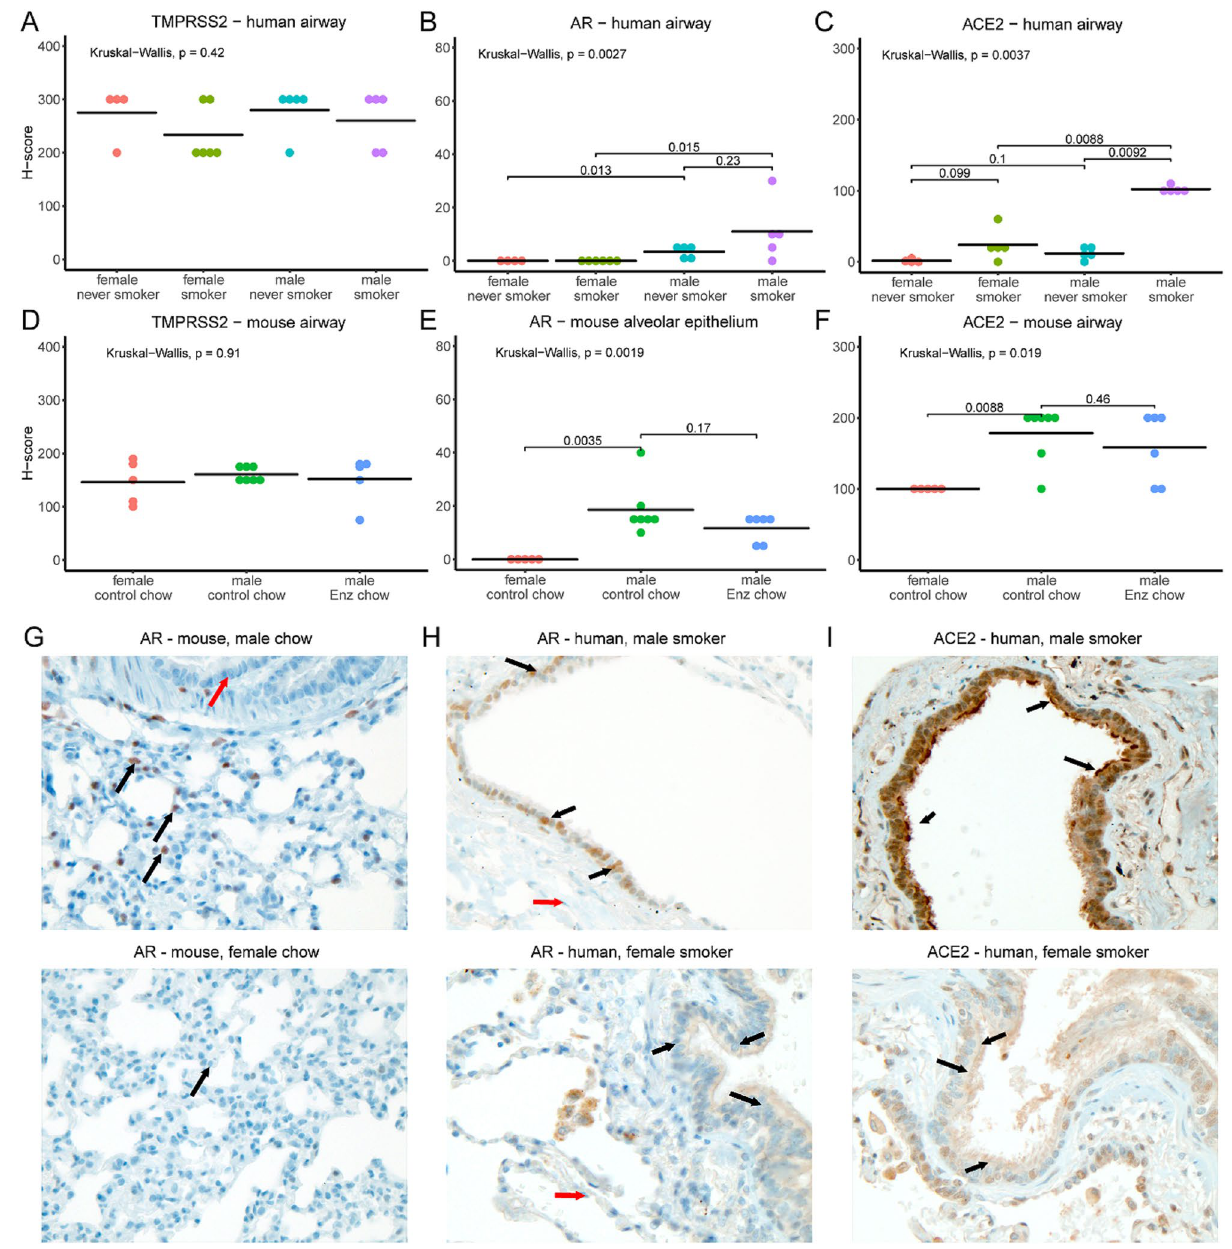
Figure 3. AR and ACE2, but not TMPRSS2, display sex-discordant patterns of immunohistochemical staining in human and mouse lung. ( A – F ) Plots of H-scores from staining for TMPRSS2 ( A , D ), AR ( B , E ), and ACE2 ( C , F ) in human ( A – C ) and mouse ( D – F ) lung samples. Note that for AR in mouse, alveolar epithelial scores are shown, as airway scores were zero for all samples; for all other panels, airway scores are shown. Humans were smokers or never-smokers as indicated. Male mice were given control chow or enzalutamide as indicated whereas female mice were given control chow. Plots show each individual data point and horizontal lines for mean values. P-values from Kruskal–Wallis tests are shown, and for plots in which Kruskal–Wallis tests suggested differences between groups, p-values from post hoc Wilcoxon tests are shown. ( G – I ) Representative images (400 × magnification) illustrating sex differences in staining. ( G ) AR staining in control male (top) and female (bottom) mice. Black arrows indicate alveolar epithelial cells with positive nuclear staining in male and negative in female. Red arrow indicates lack of staining in bronchiolar epithelial (airway) cells. ( H ) AR staining in human male smoker (top) and female smoker (bottom). Black arrows indicate airway epithelial cells with positive nuclear staining in male and absence of staining in female. Red arrows indicate alveolar epithelial cells negative in both. ( I ) ACE2 staining in human male smoker (top) and female smoker (bottom). Black arrows indicate positive apical membrane staining in male airway epithelial cells and absence of staining in female airway epithelial